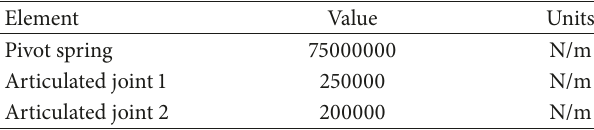
Table 6: Stiffness values of the traction rod force